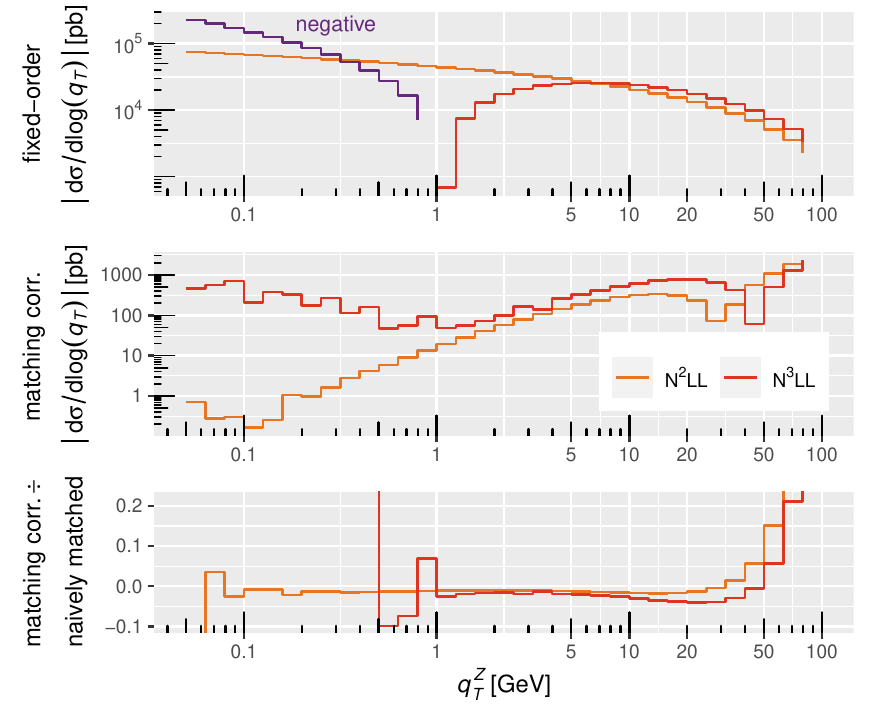
Figure 5. Top panel: fixed-order prediction at LO and NLO for inclusive Z production. Middle panel: absolute matching corrections to show the cancellation towards q T → 0 and the effect of a limited numerical accuracy at small q T . Bottom panel: matching corrections relative to the naively matched